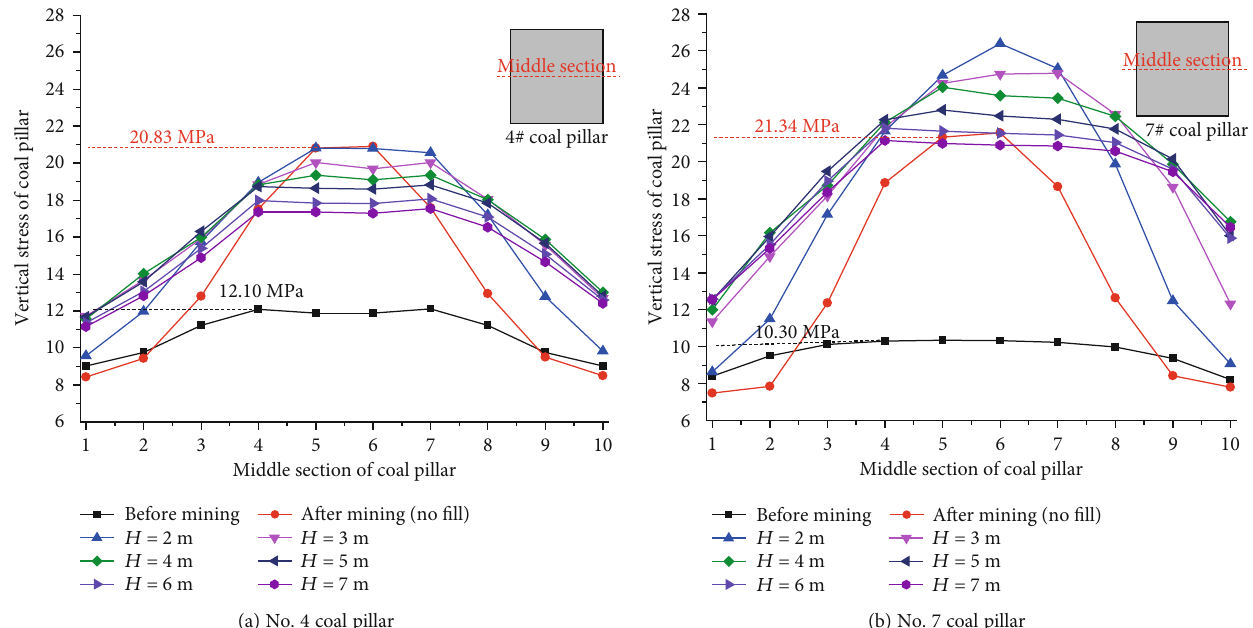
Figure 12: Strengthening e ff ect of di ff erent fi lling body heights on coal pillar ’ s bearing